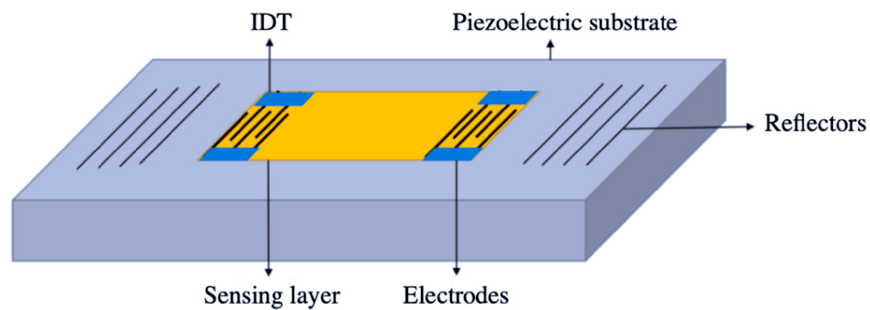
Figure 3. Schematic representation of a SAW gas sensor with two arrays or reflectors and a piezoelectric substrate. Reprinted from ref [7]. Copyright 2019, S ensors by MDPI. substrate. Reprinted from ref [7]. Copyright 2019, Sensors by